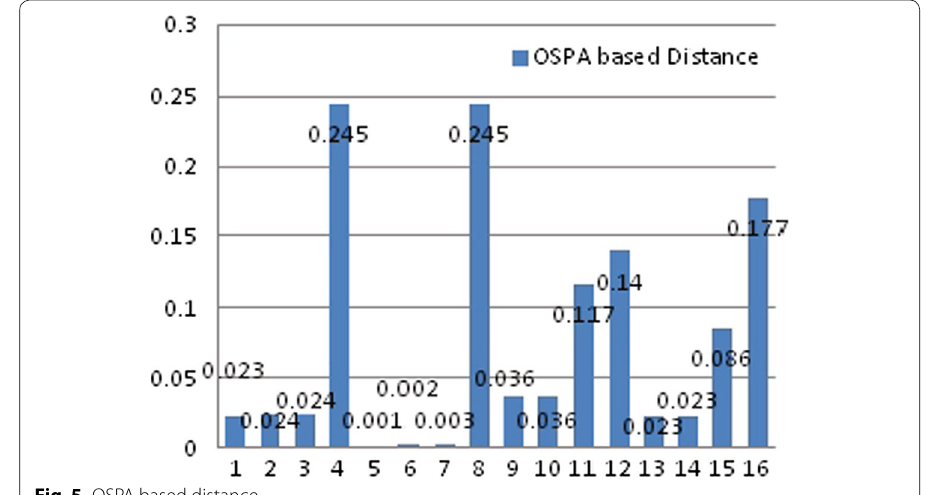
Fig. 5 OSPA based distance